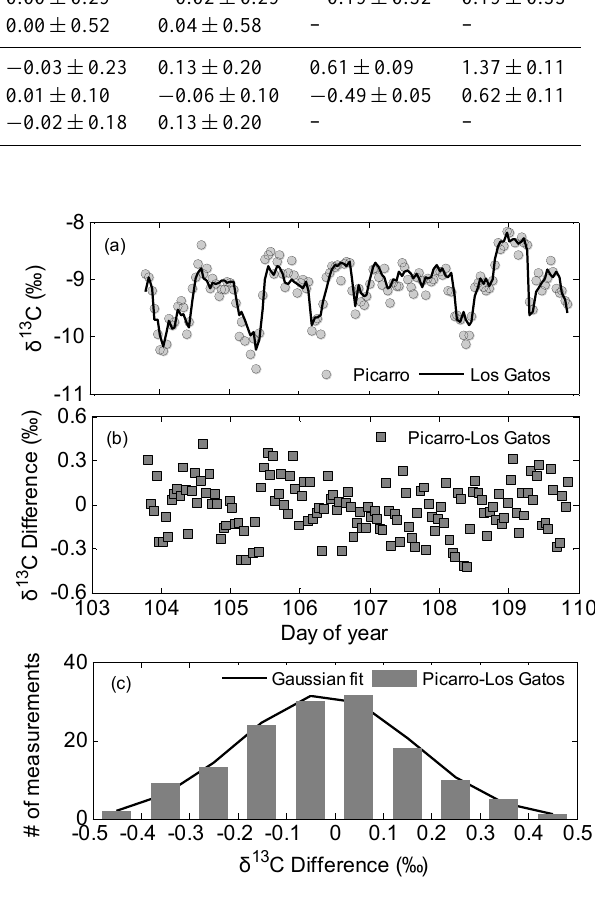
Fig. 2. Time variations of (a) hourly atmospheric δ 13 C in Beijing during DOY 103-110 in 2012, (b) difference between the Picarro G1101-i and the Los Gatos DLT-100 analyzer, and (c) histogram of the differences. Here Method 1 was used for